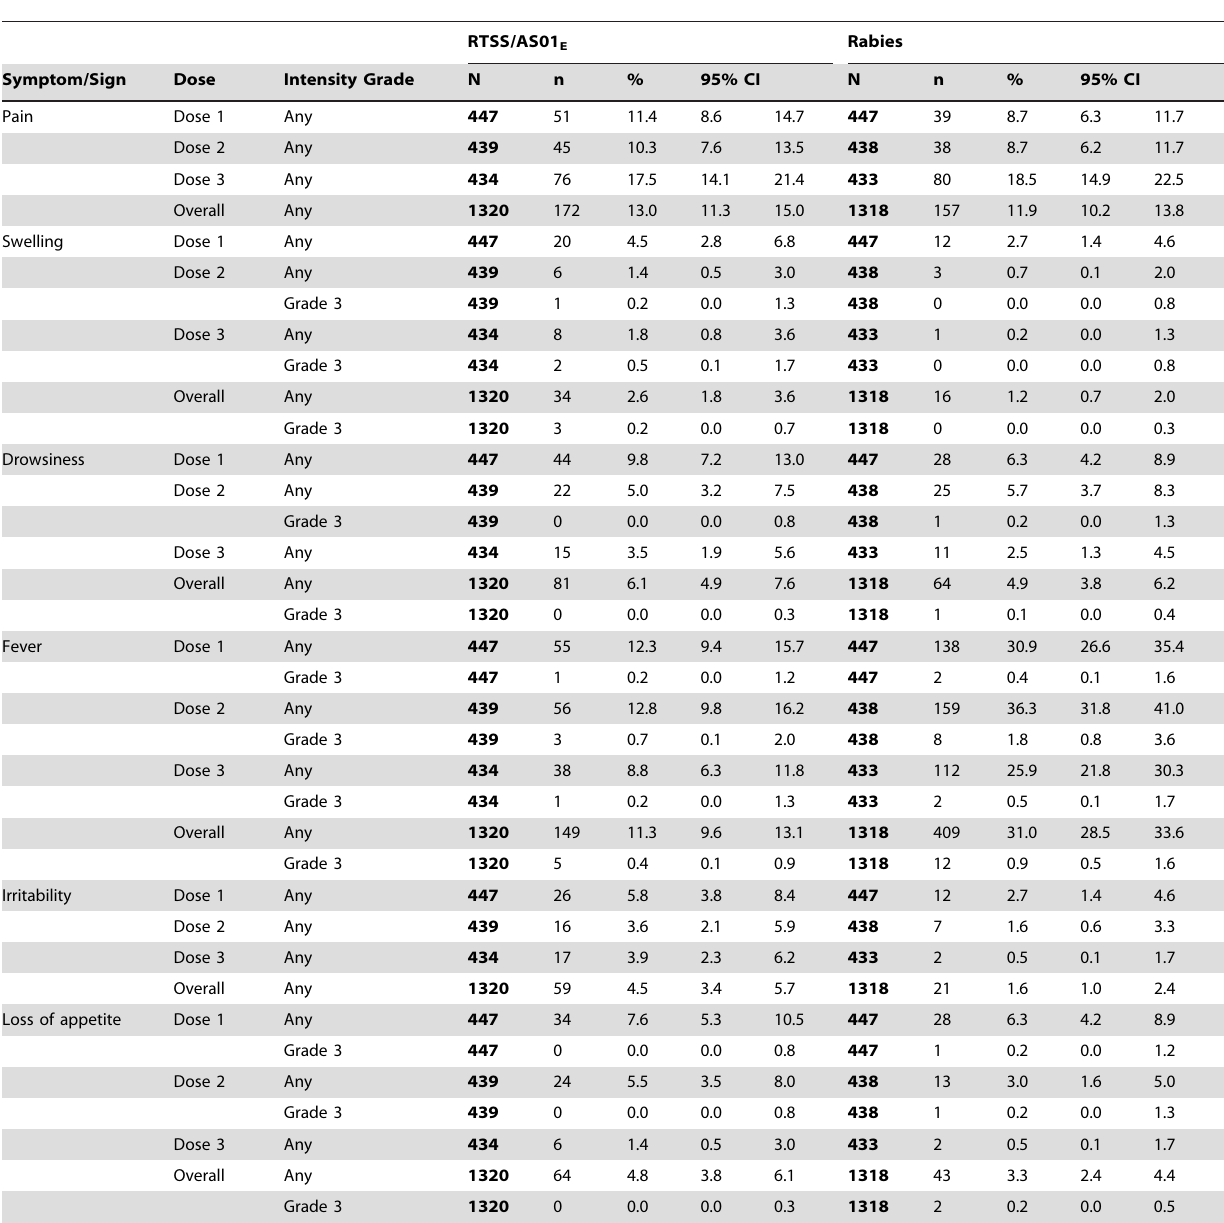
Table 4. Frequency (%) of solicited local and general adverse events within 7 days following each dose and overall.